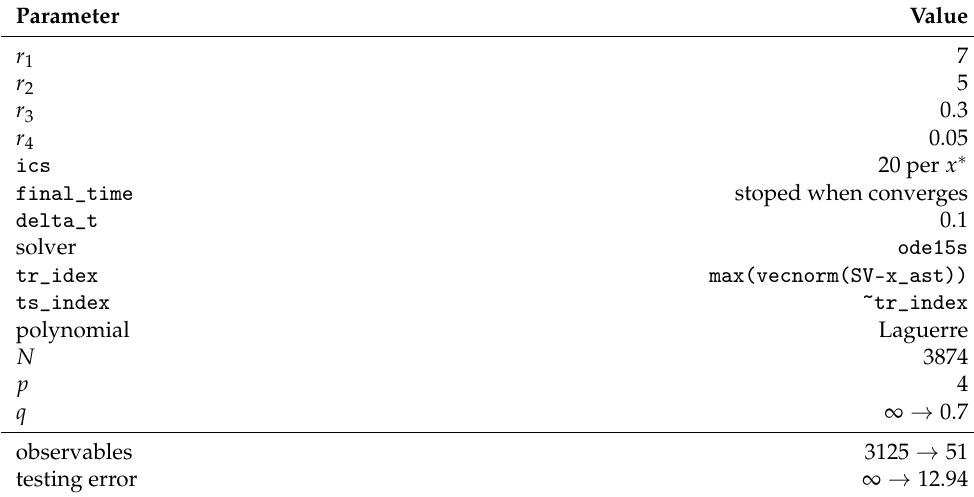
Table 4. Approximation parameters for the reaction